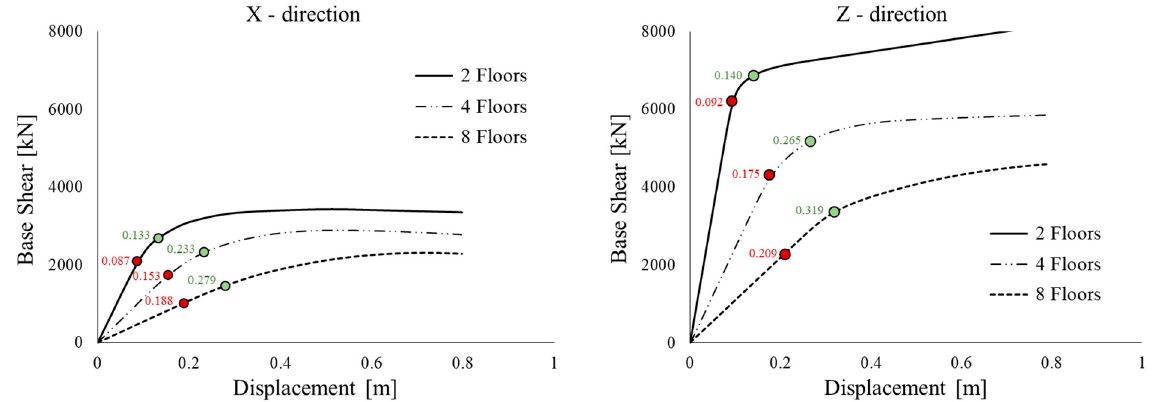
Figure 4. MODAL capacity curves of the as-built structures (MDOF) with indications of the target displacement 𝑑 (cid:3043) (green dots) and the yield displacement 𝑑 (cid:3052) (red dots).